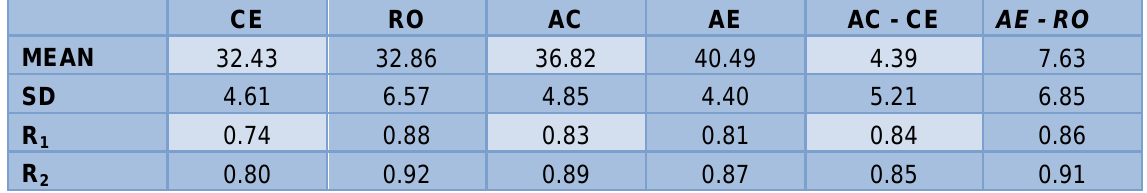
Table 6 Means, Standard Deviations and Reliabilities for Kolb's Learning Style Inventory - 1985 revised subscales (n = 84) R1 = Cronbach's Alpha, R2 = Spearman-Brown split